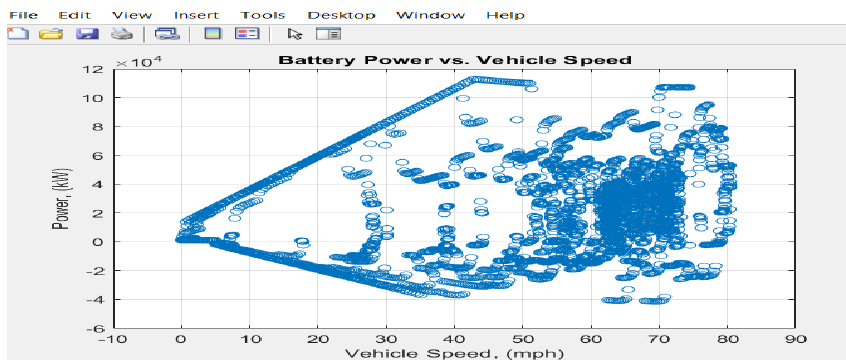
Figure 16. Power consumption versus vehicle’s speed.